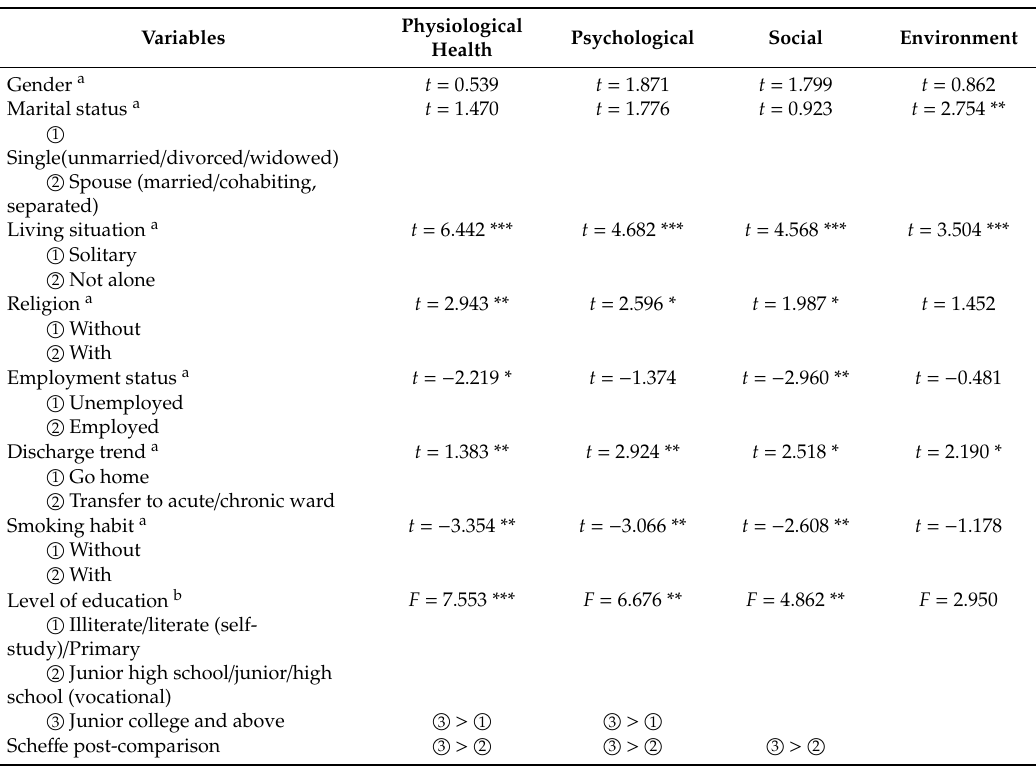
Table 3. Correlation between sociodemographic characteristics, health status, risk of disability, patient continuity of care, and QoL among patients with coronary heart disease ( N =